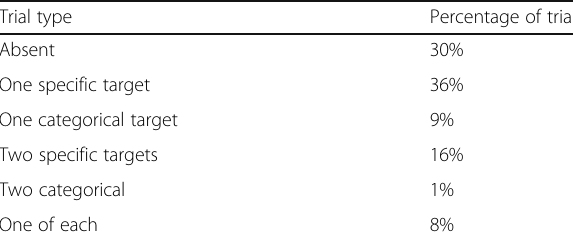
Table 2 The distribution of trial types in Experiment